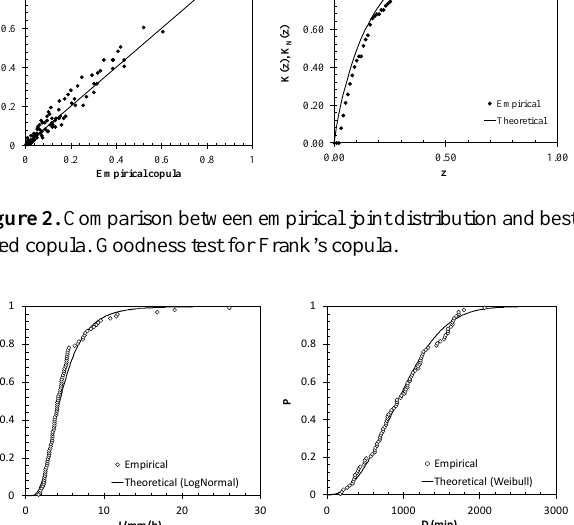
Table 1. Information and statistics of the rainfall data for 80 events registered from 2010 to 2011.